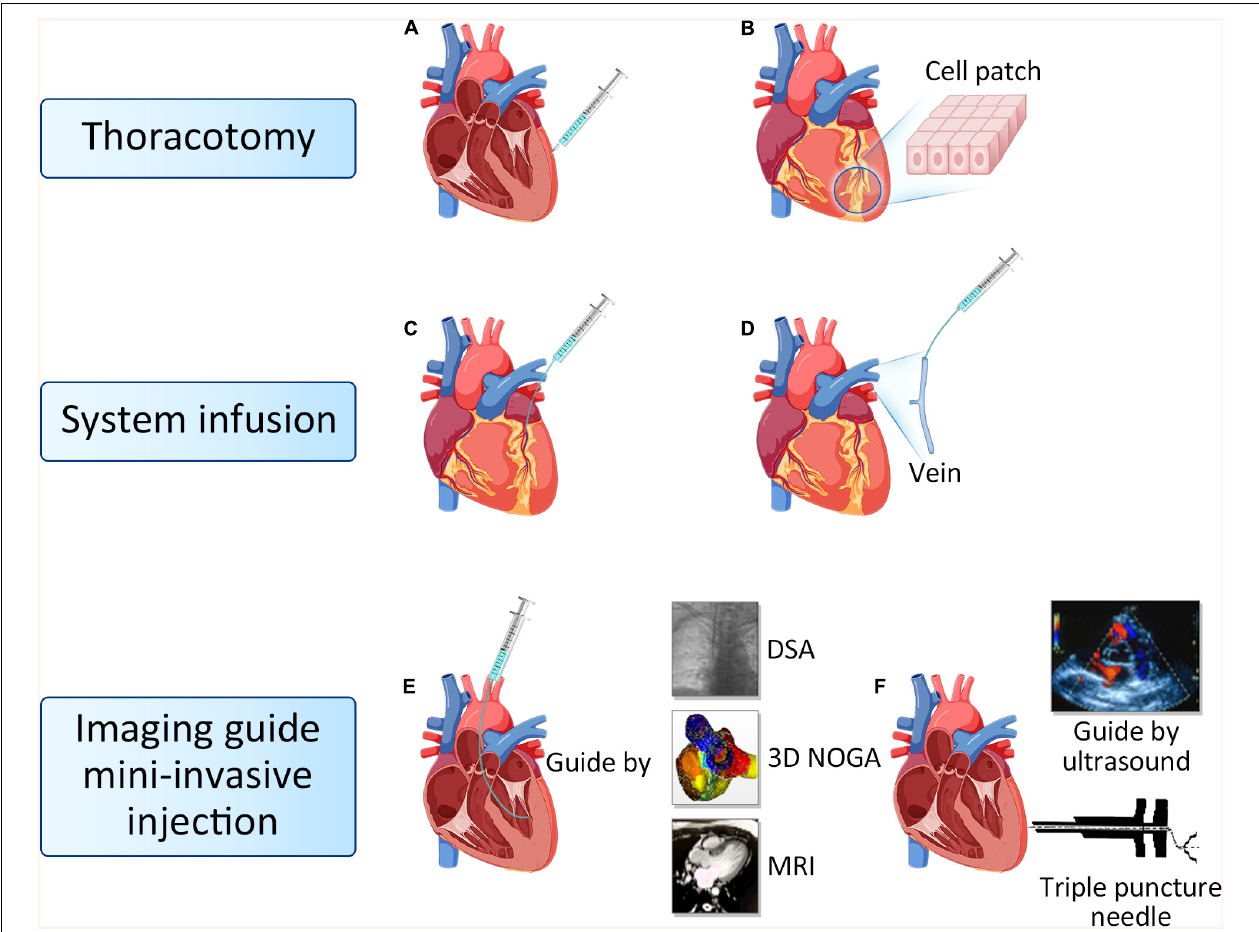
FIGURE 2 | Route of cell delivery. (A) Epicardial intramyocardial injection. (B) Biological tissue engineering and cell patch. (C) Intracoronary injection. (D) Intravenous injection. (E) Endocardial intramyocardial injection guide by DSA, 3D NOGA and MRI. (F) Ultrasound guided targeted epicardial injection with a triple puncture needle device. DSA, Digital subtraction angiography; MRI, Magnetic resonance